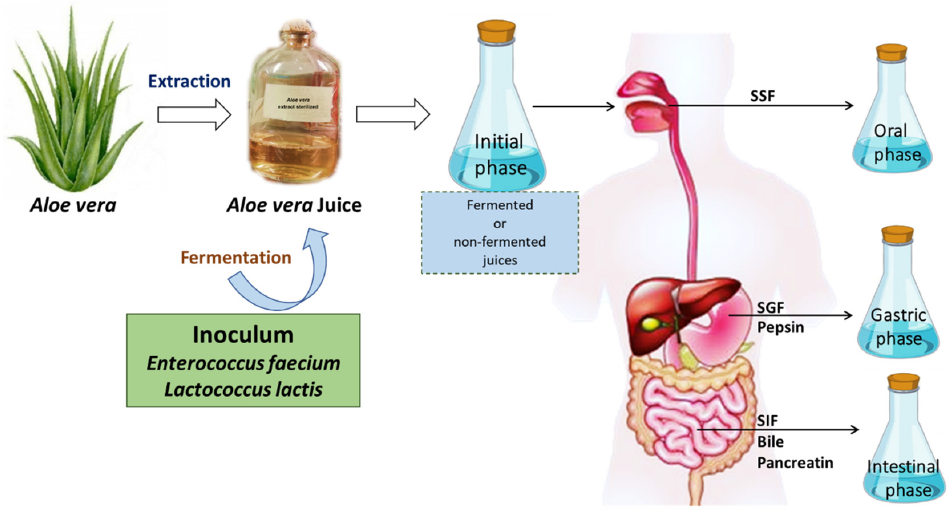
Figure 1. Juice preparation procedure and in vitro gastrointestinal digestion (static model) of non- fermented Aloe vera and Aloe vera fermented either with Enterococcus faecium or with Lactococcus lactis